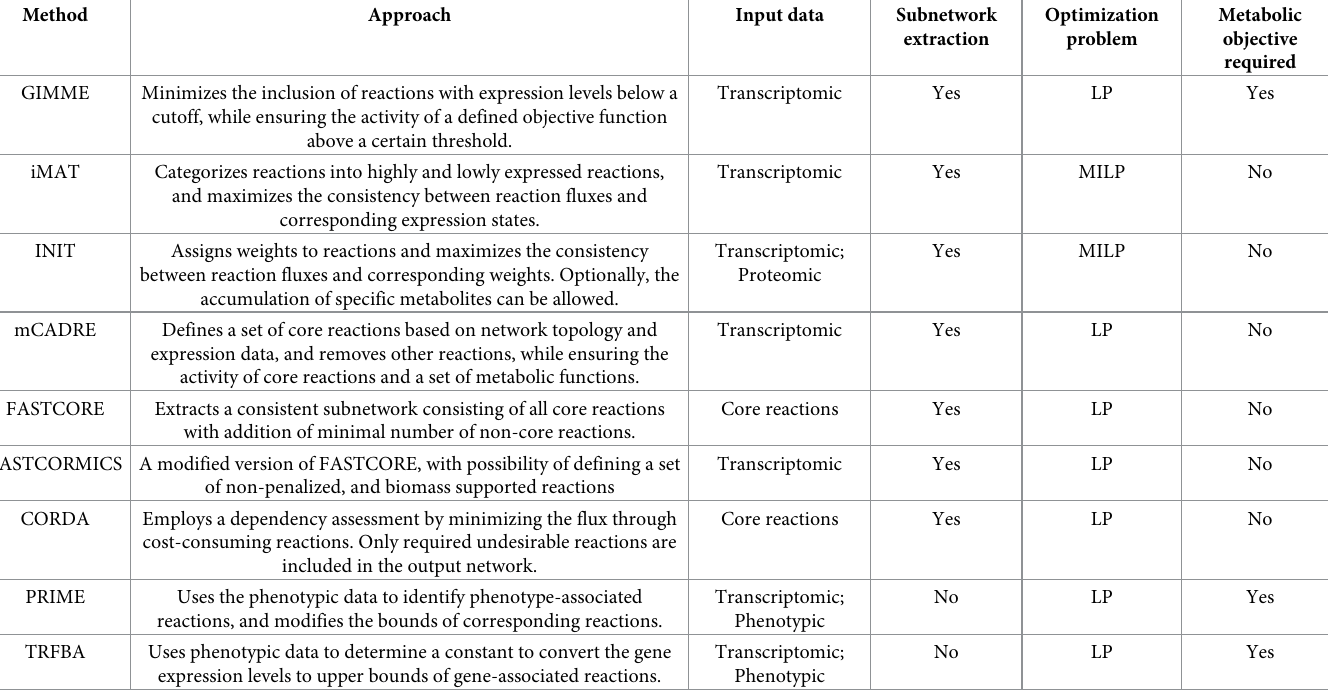
Table 1. An overview of the Context-specific reconstruction methods studied here. Method